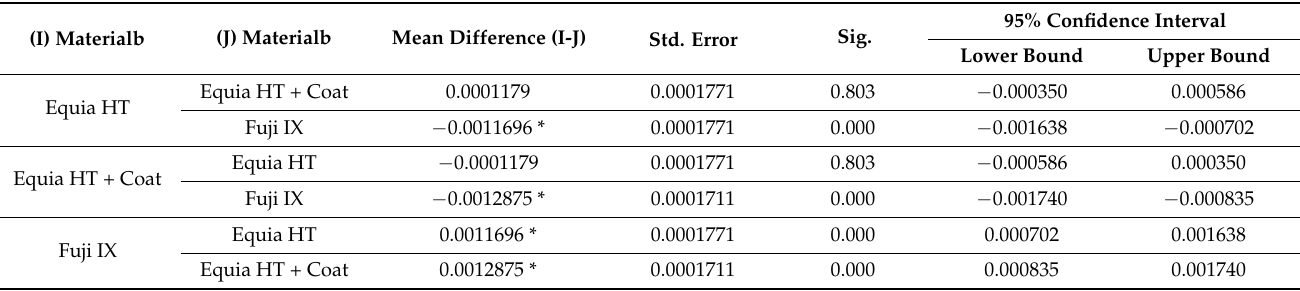
Table 4. Analysis of the effect of acid load on the wear of samples stored in artificial saliva.